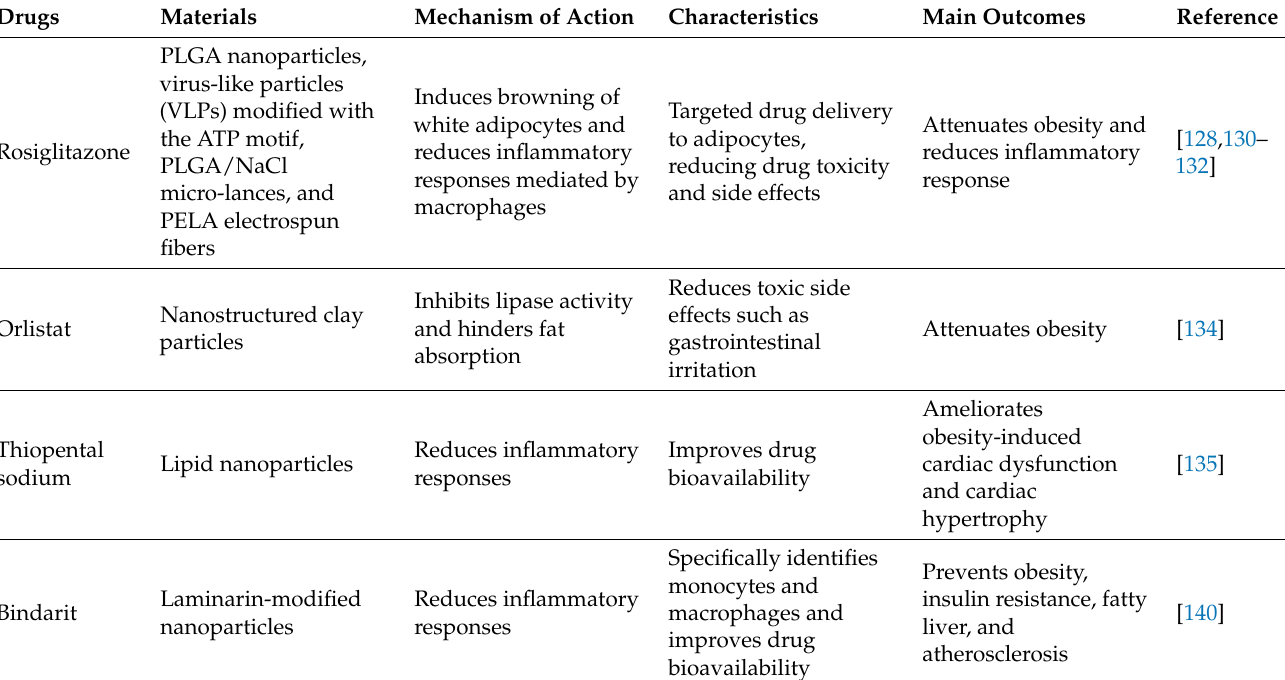
Table 4. Biomaterial-encapsulated synthetic drugs for anti-obesity